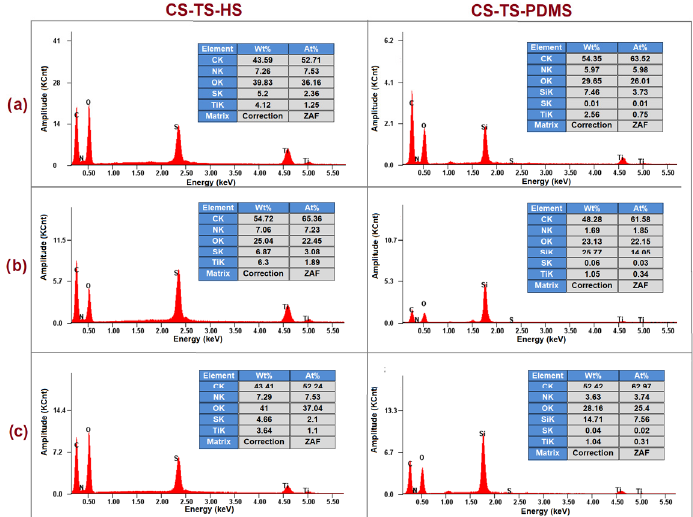
Figure 3. EDX spectra and elemental compositions of CS-TS-HS ( left ) and CS-TS-PDMS ( right ) composite membranes ( a ) polymer/glass interface, ( b ) cross-section, and ( c ) polymer/air interface.